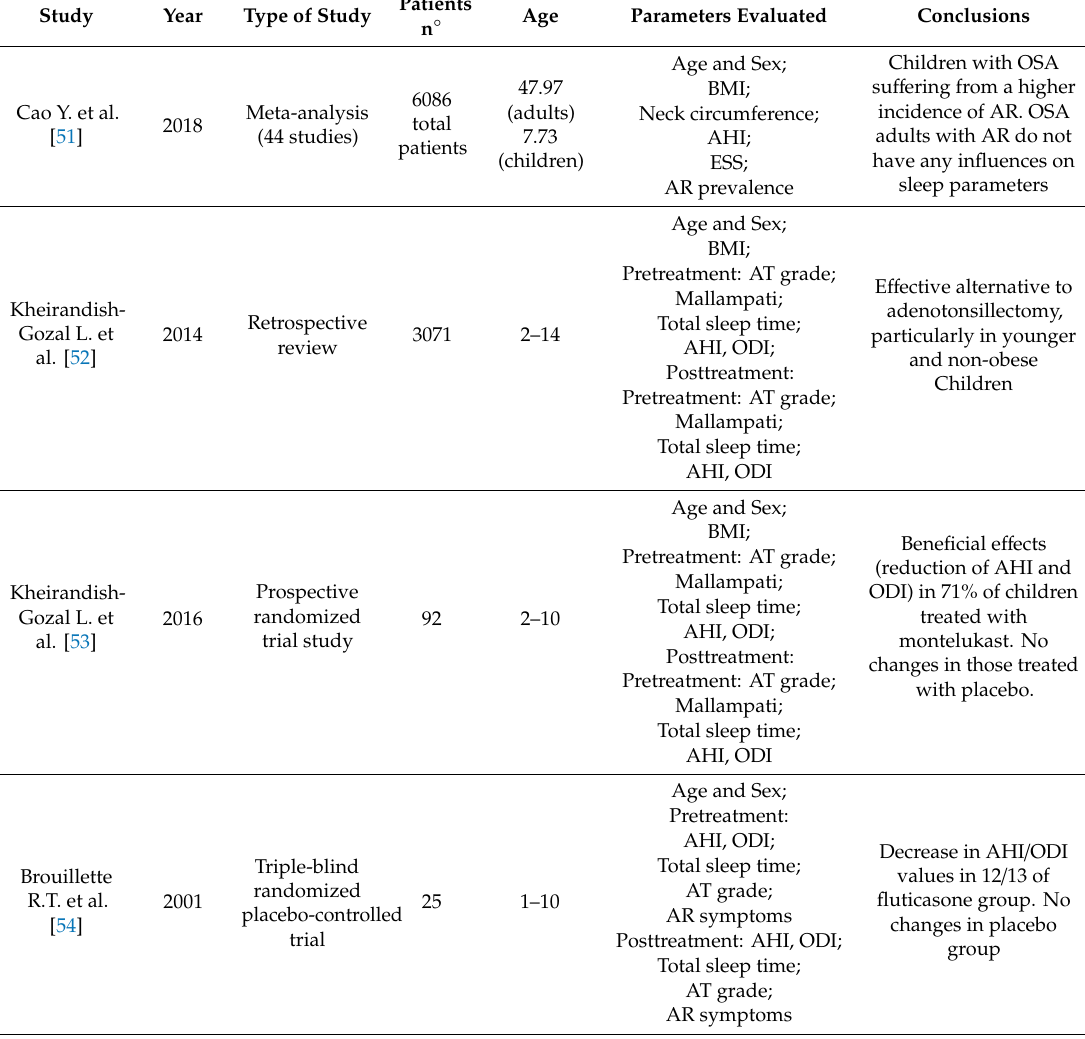
Table 4. Studies that have analyzed allergic rhinitis as a pediatric OSA risk